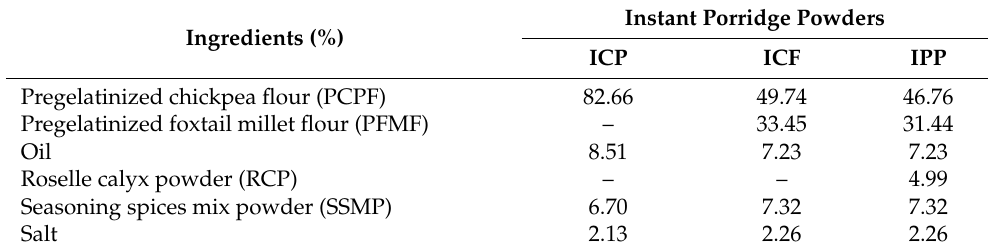
Table 1. Ingredients of three different instant porridge powder